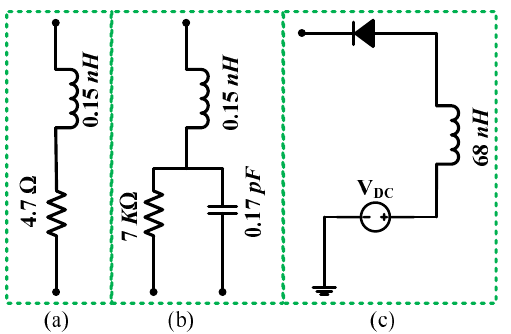
Figure 4. Equivalent model of diode for ( a ) ON-state ( b ) OFF-state ( c ) biasing